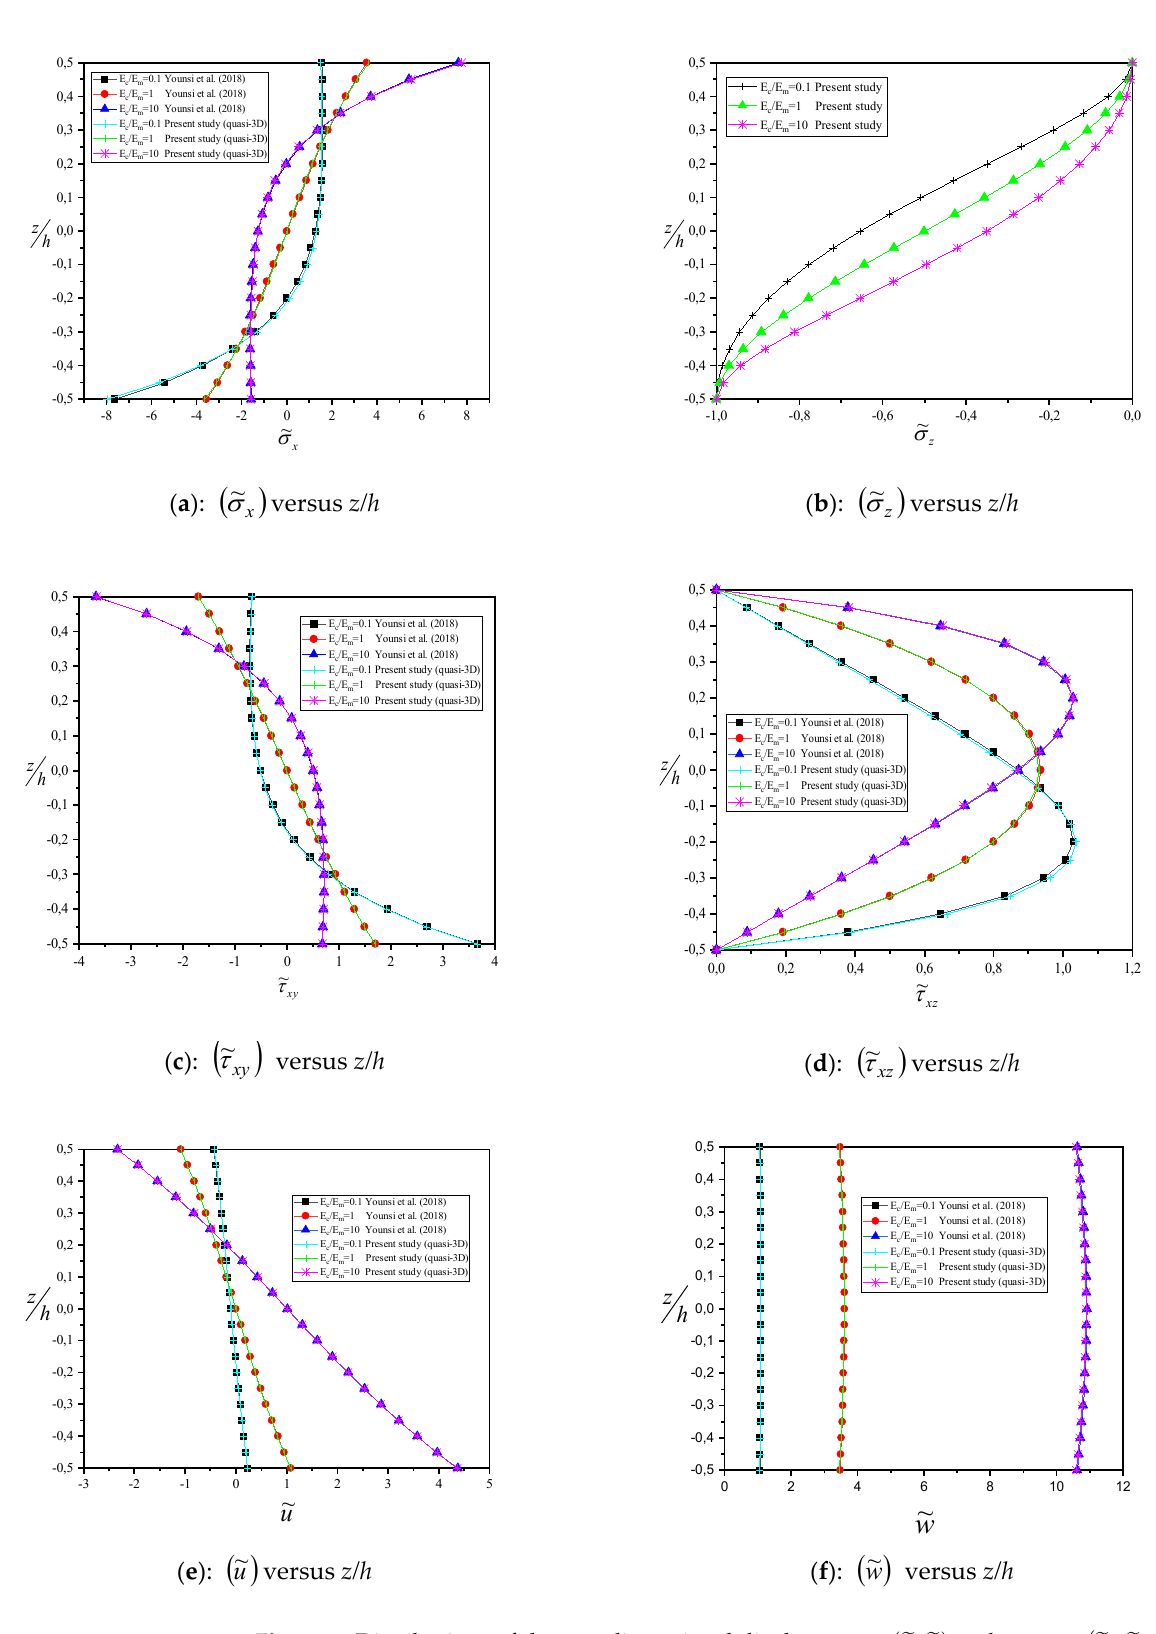
Figure 4. Distributions of the non-dimensional displacements ( (cid:101) u , (cid:101) w ) and stresses through the thickness of square E-FGM plate ( a / h = 10)